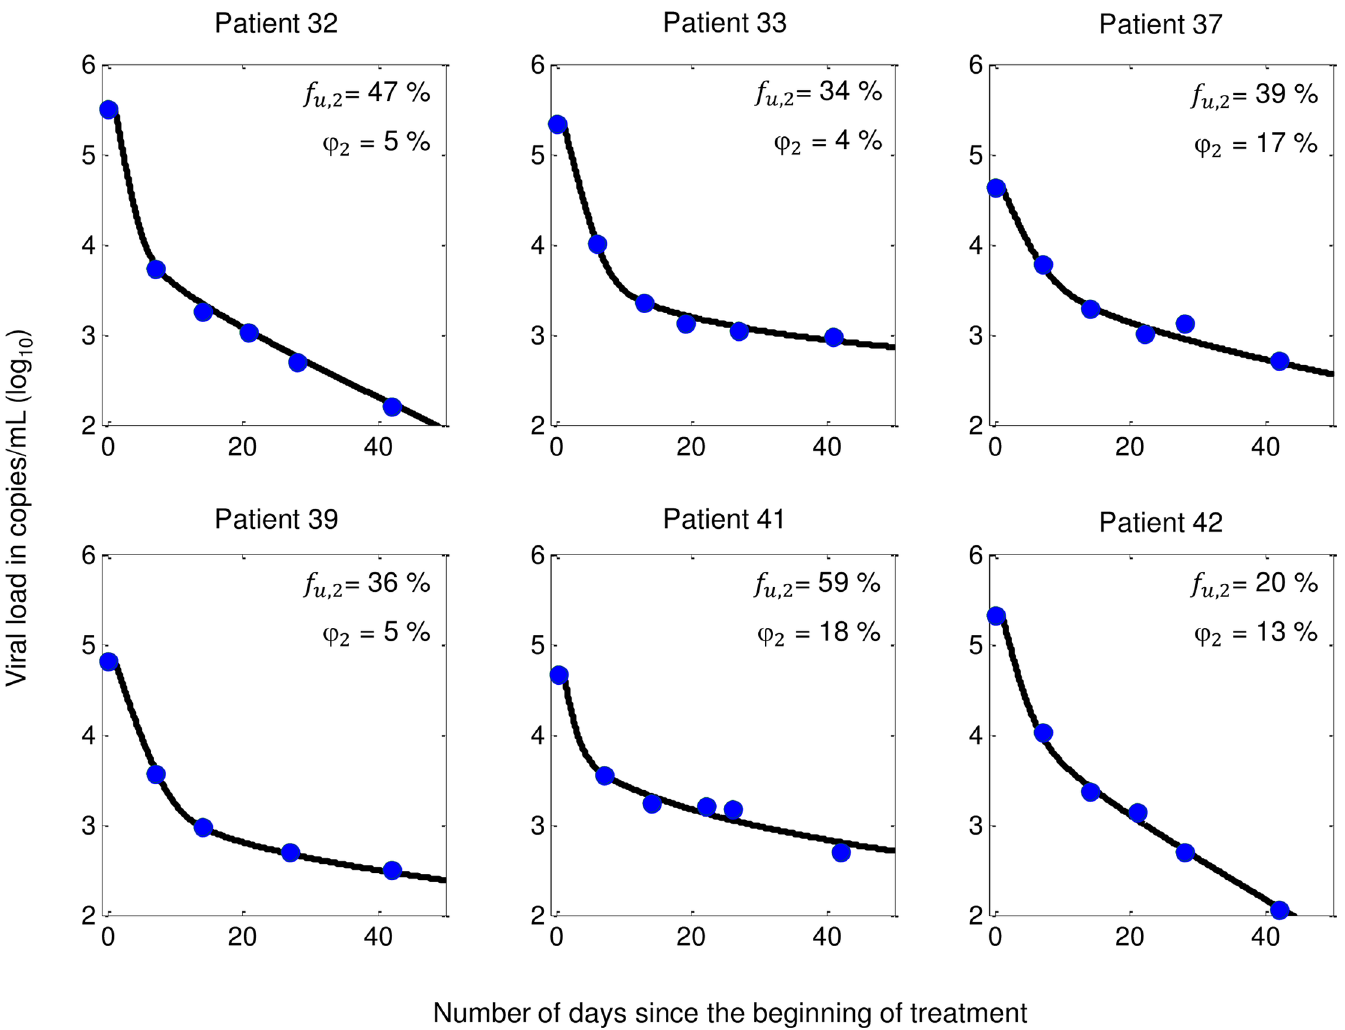
Fig 2. Viral load data extracted from Perelson et al.[1] (blue dots), model fit (black curve), and associated f infection events not affected by the drugs and φ 2 is the fraction of the plasma viral load setpoint. Both parameters refer to the drug-limited